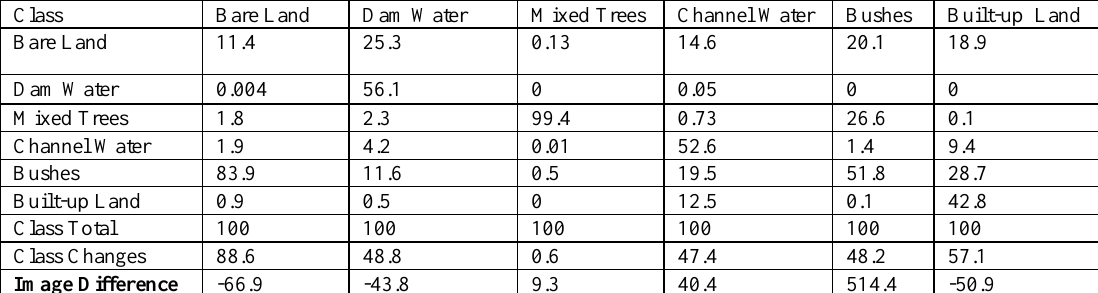
Figure 7. Change detection results of OLI SVM classified data from from summer to autumn